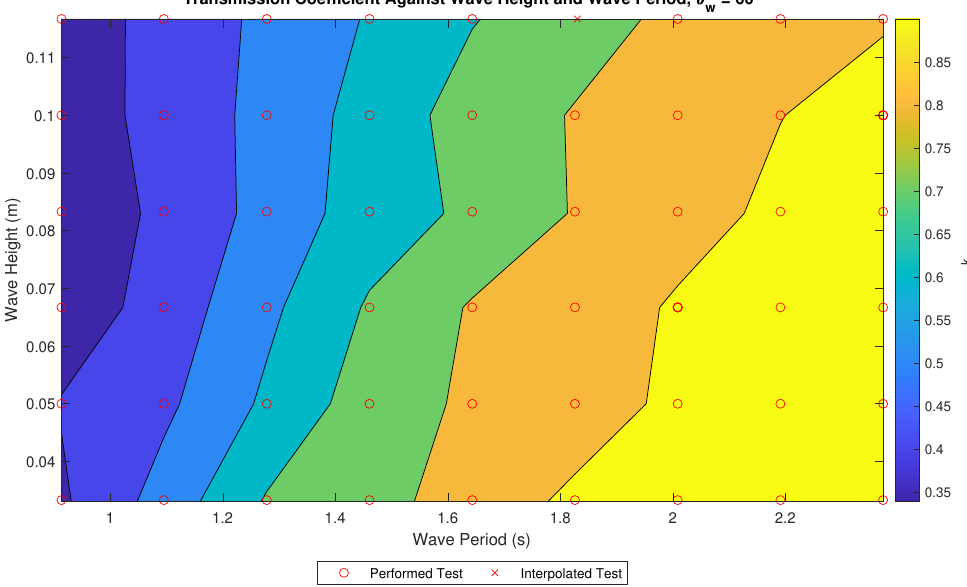
Figure 9. K t against significant wave height and peak wave period. Figure 12 shows the power matrix when the results from Figure 11 are scaled from model scale to full scale. Peak power is approximately 64.6 kW during the test of H s = 3.5 m and T p = 6 s. As T p is increased, such that wavelength is longer than the model length, the power generation is lower than that of the peak test but remain